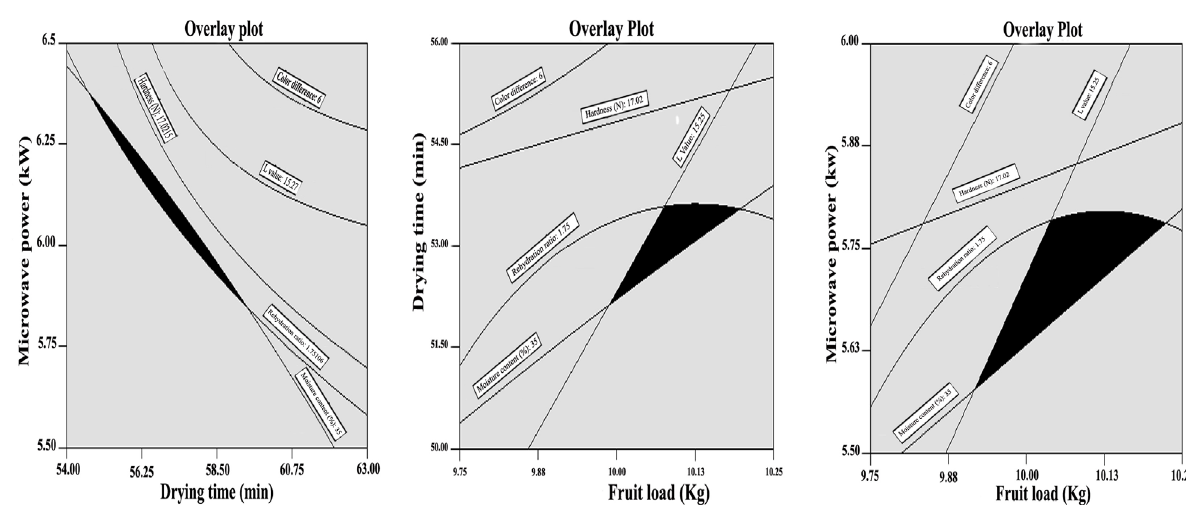
Figure 3 Graphical optimization (shaded area) of microwave power, drying time and fruit load for the moisture content, rehydration ratio, hardness, L value and total color difference of the microwave-vacuum dried Saskatoon